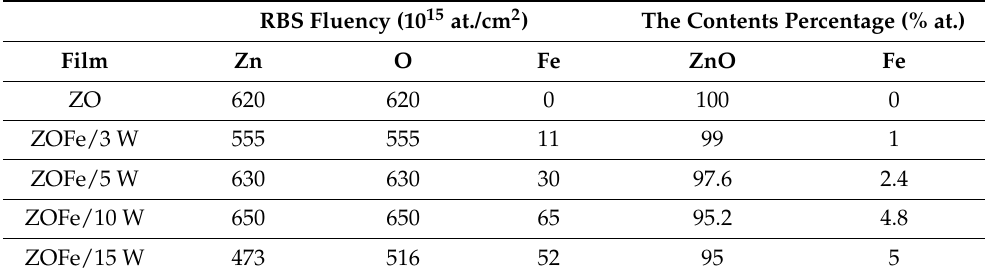
Table 2. RBS results for the estimation of Zn and Fe content (at. %) in the investigated films. RBS Fluency (10 15 at./cm 2 ) The Contents Percentage (% at.)